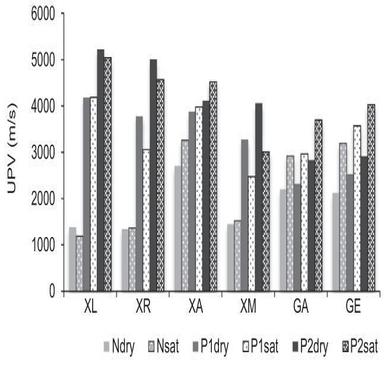
UPV results for dry and water saturated conditions.